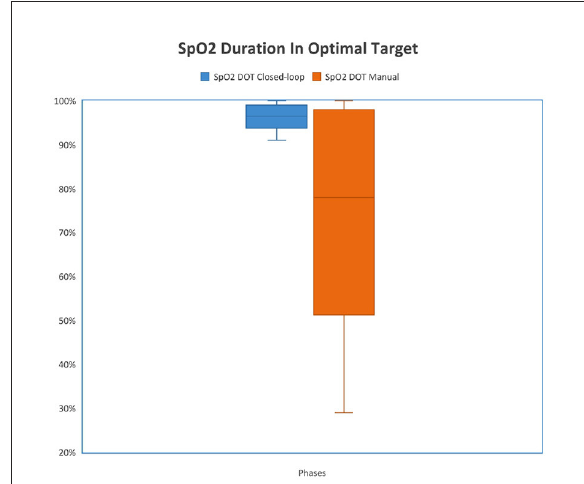
FIGURE3 Comparison of duration in optimal target (DOT) SpO2 between study phases. {The median percentage of time spent in the optimal zone was 96.4% [93.6–98.7 (IQR)] when the FiO2 controller was activated and the median percentage of time spent in the optimal zone was 78.4% [51.4–98 (IQR)] when FiO2 was controlled manually ( p < 0.001)}.